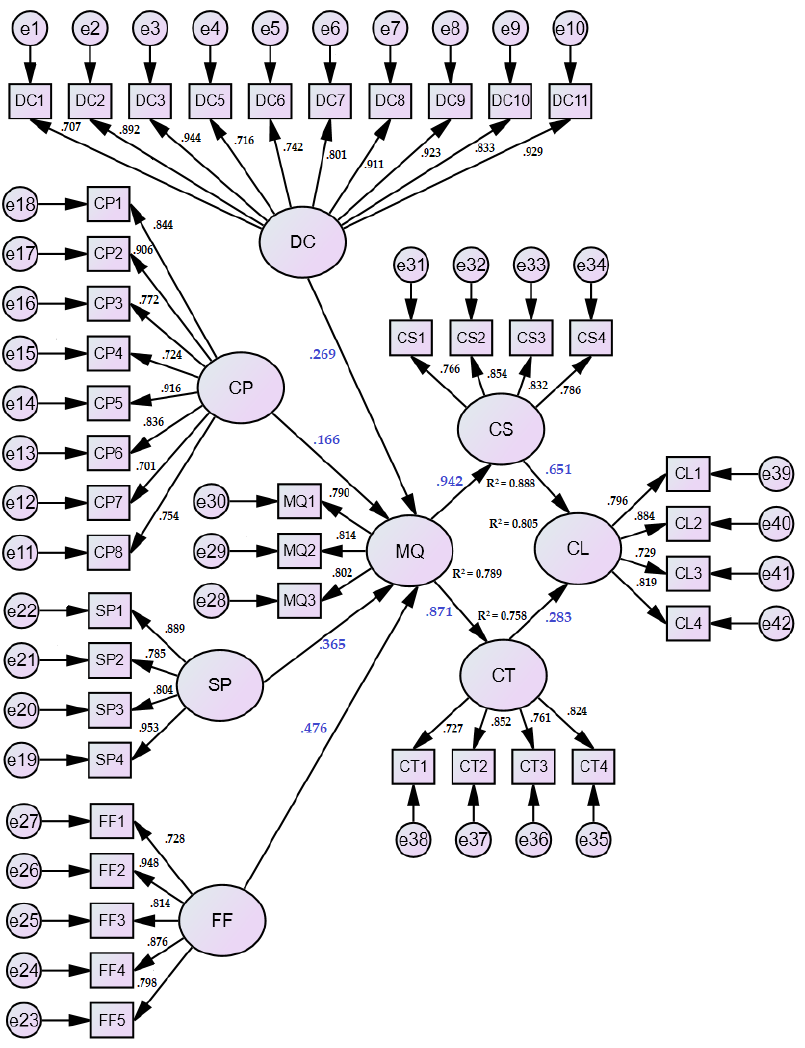
Figure 2. SEM measurement model. Source: developed using SPSS Amos v.26.0.